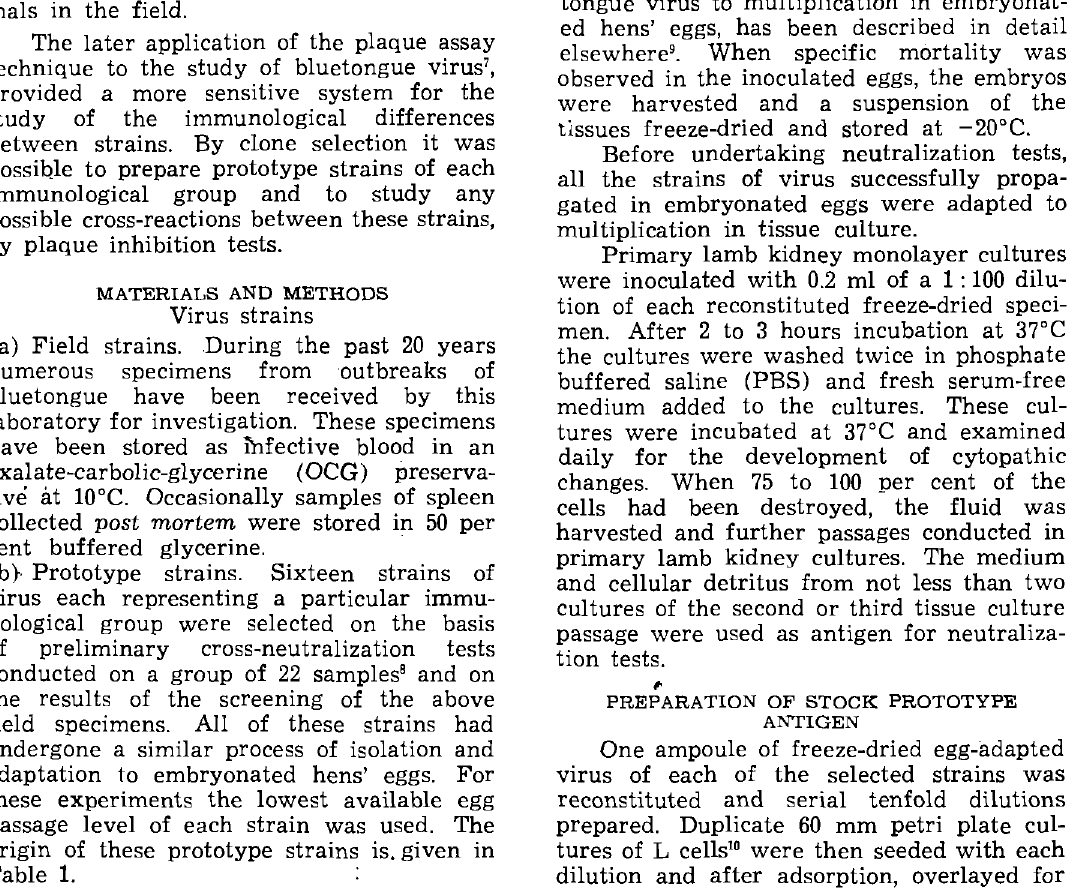
Table I: ORIGIN AND IDENTIFICATION OF SELECTED PROTOTYPE